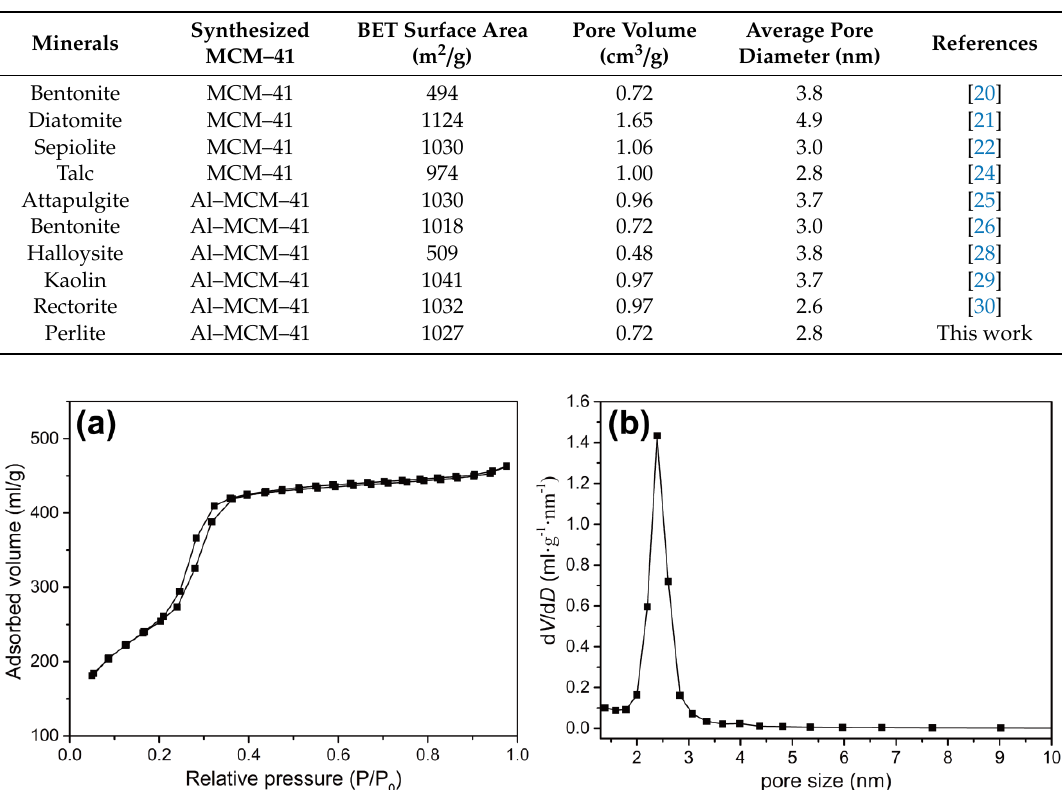
Table 1. Comparison of porous parameters of MCM–41 from various minerals.